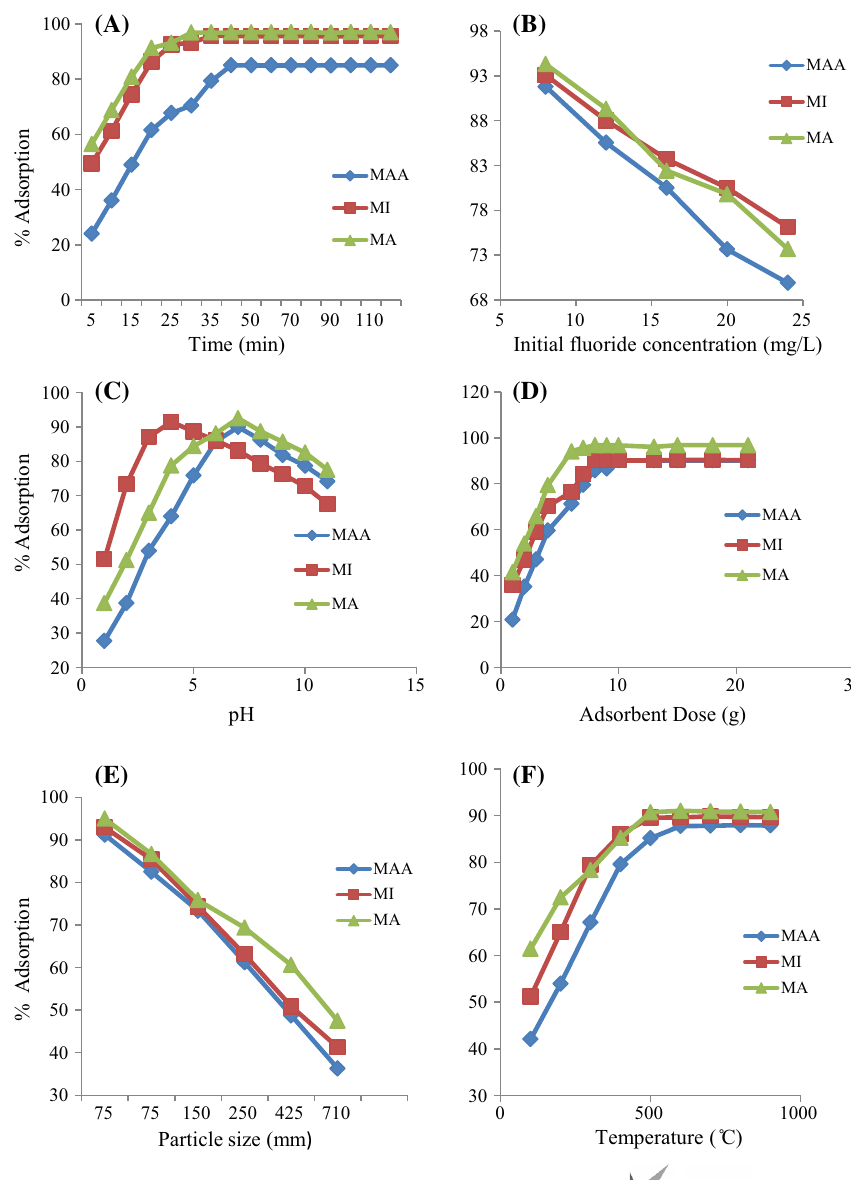
Fig. 3 Percentage adsorption of MAA, MI and MA versus a contact time, b initial fluoride concentration, c pH, d adsor- bent dosage, e particle size and f